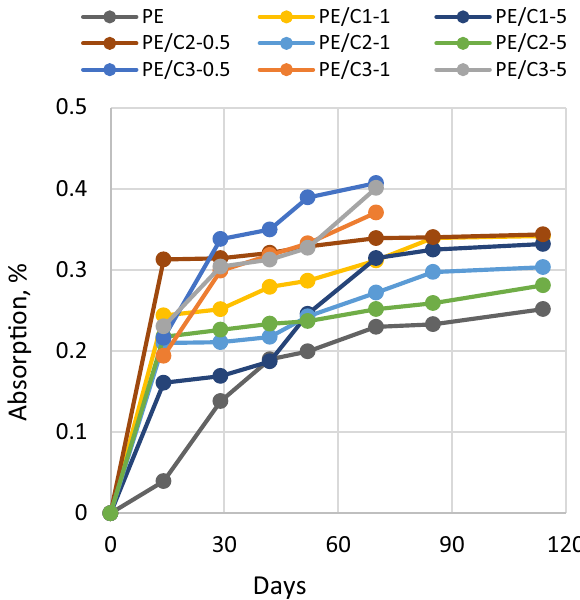
Figure 2. Moisture sorption of bio-PE with ILs at RH 50%.